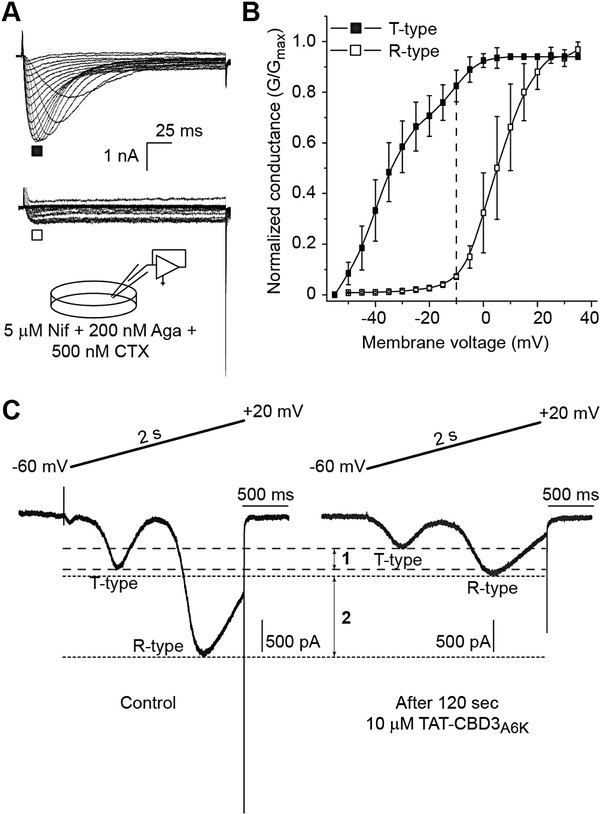
Pharmacological and biophysical dissection of TAT-CBD3A6K-mediated block of T-and R-type calcium currents in DRG neurons. (A) Representative T- (top) and R-type (bottom) current traces obtained from two separate DRG neurons evoked by 200 ms steps in 5 mV increments from −60 mV to +50 mV, from a holding potential of −90 mV. The extracellular bath solution contained 5 mM Nifedipine (Nif), 200 nM ω-Agatoxin IVA (Aga) and 500 nM ω-Conotoxin GVIA (CTX) to block L-, P/Q-, and N-type calcium currents, respectively. (B) Summary of the normalized conductance (G) versus voltage relations for DRG neurons with T- (filled squares) or R- (open squares) type calcium currents. The dotted line at −10 mV highlights the clear discrimination in conductances between T- and R-type currents. (C) Representative currents, evoked by a ramp depolarizations from −60 mV to +20 mV for 2 s, illustrating the presence of both T- and R-type currents in the same DRG neuron before (left trace) and 2 min after application 10 μM TAT-CBD3A6K (right trace)